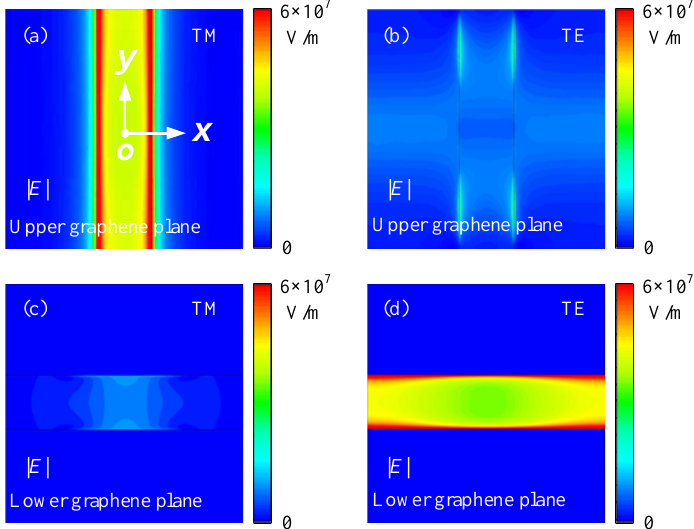
Figure 6. Electric field distributions of the absorber with DLDGRAs at μ c = 0.3 eV under normal incidence, where ( a ) and ( c ) are respectively the | E | for the TM polarization along the upper and lower graphene planes at the absorbance peak frequency of 6.81 THz; ( b ) and ( d ) are the | E | for the TE polarization along the upper and lower graphene planes at the absorbance peak frequency of 5.62 THz, respectively.